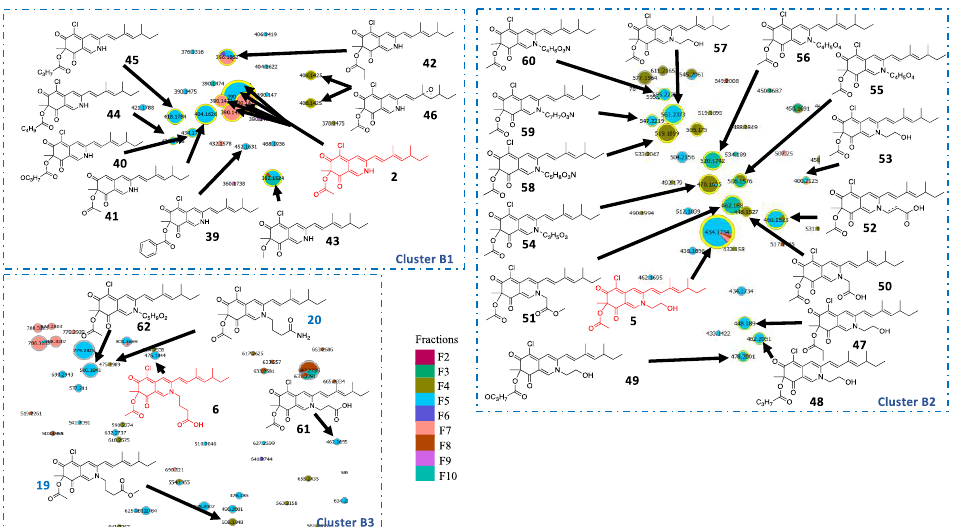
Figure 4. Proposed fragmentation pathway of molecules in clusters A and B. Depending on R 1 , X and Y elements. NL = neutral loss, F = fragmentation (below).